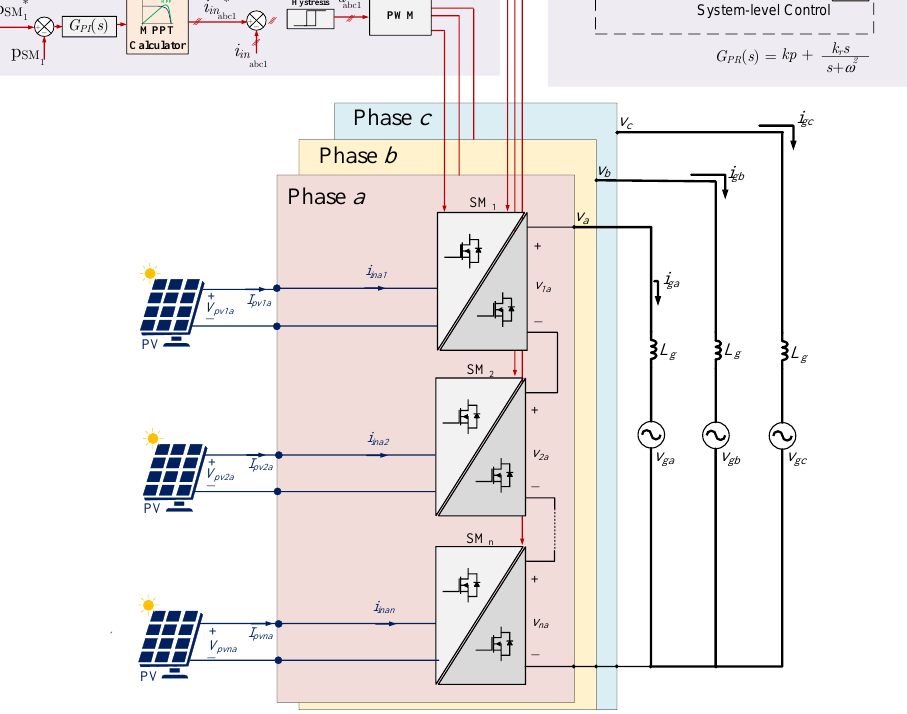
Figure 24. SM control during Mode 4. Figure 25 shows the MATLAB/SIMULINK simulation results for a case study when the power of the PV modules is increased gradually from 0 at t=0s to 100% at t = 0.1s. To simulate the transient response, the PV modules’ powers are reduced to 60% at t = 0.3s. Figure 25a shows the total power of the PV farm. Figure 25b shows the CMC output power with the grid current. Figure 25c shows the input current of the first PV array, which is connected to SM1. Figure 25d shows the PV curves with the associated operational points.